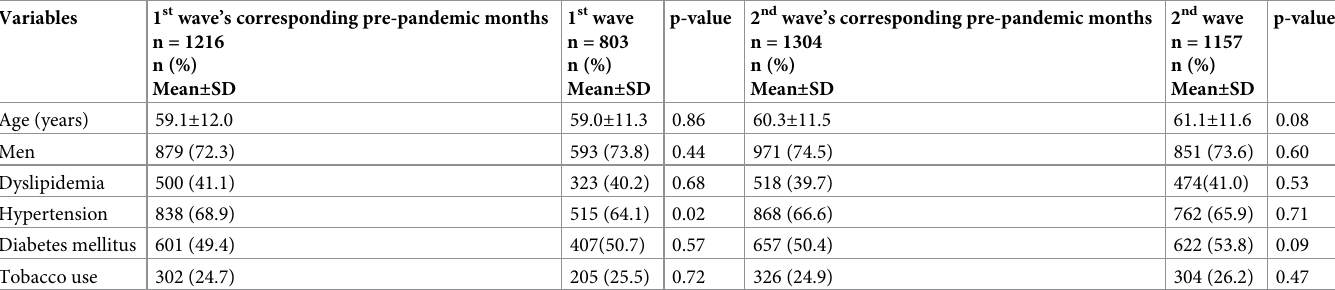
Table 1. Baseline characteristics of ACS patients between pre-pandemic months matched to 1 st and 2 nd COVID waves.